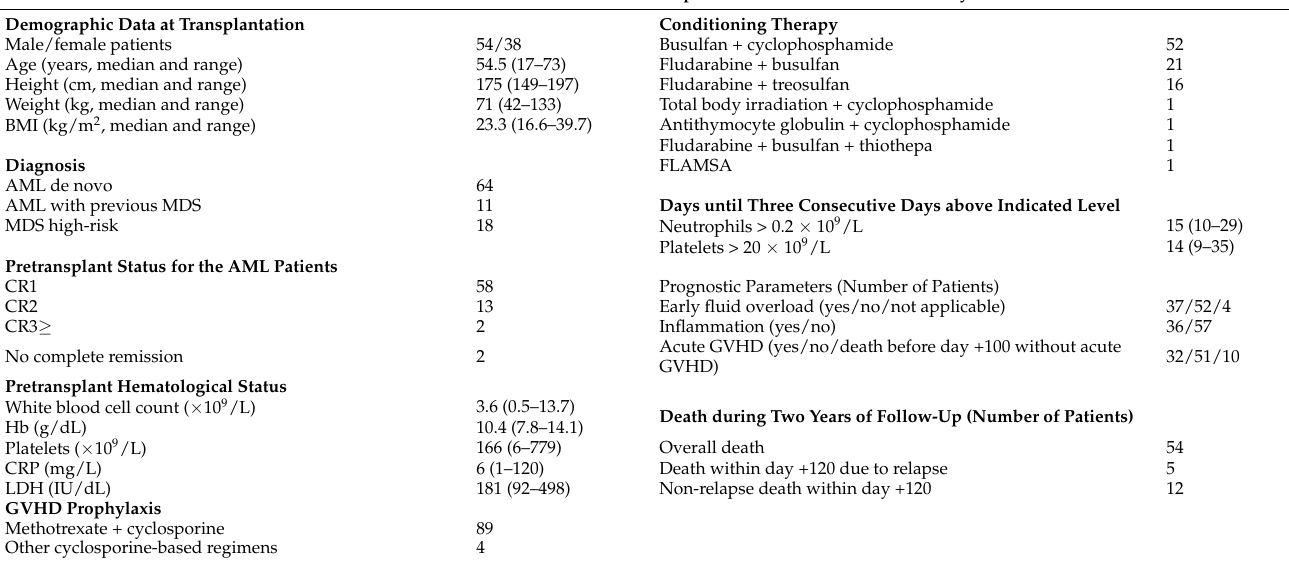
Table 1. Characteristics of the 92 patients (93 allotransplantations *) included in the study. Unless otherwise stated, the data are presented either as the number of patients or median (variation range) for the indicated parameter. One of the AML patients transplanted with detectable leukemia was treated according to the FLAMSA sequential treatment